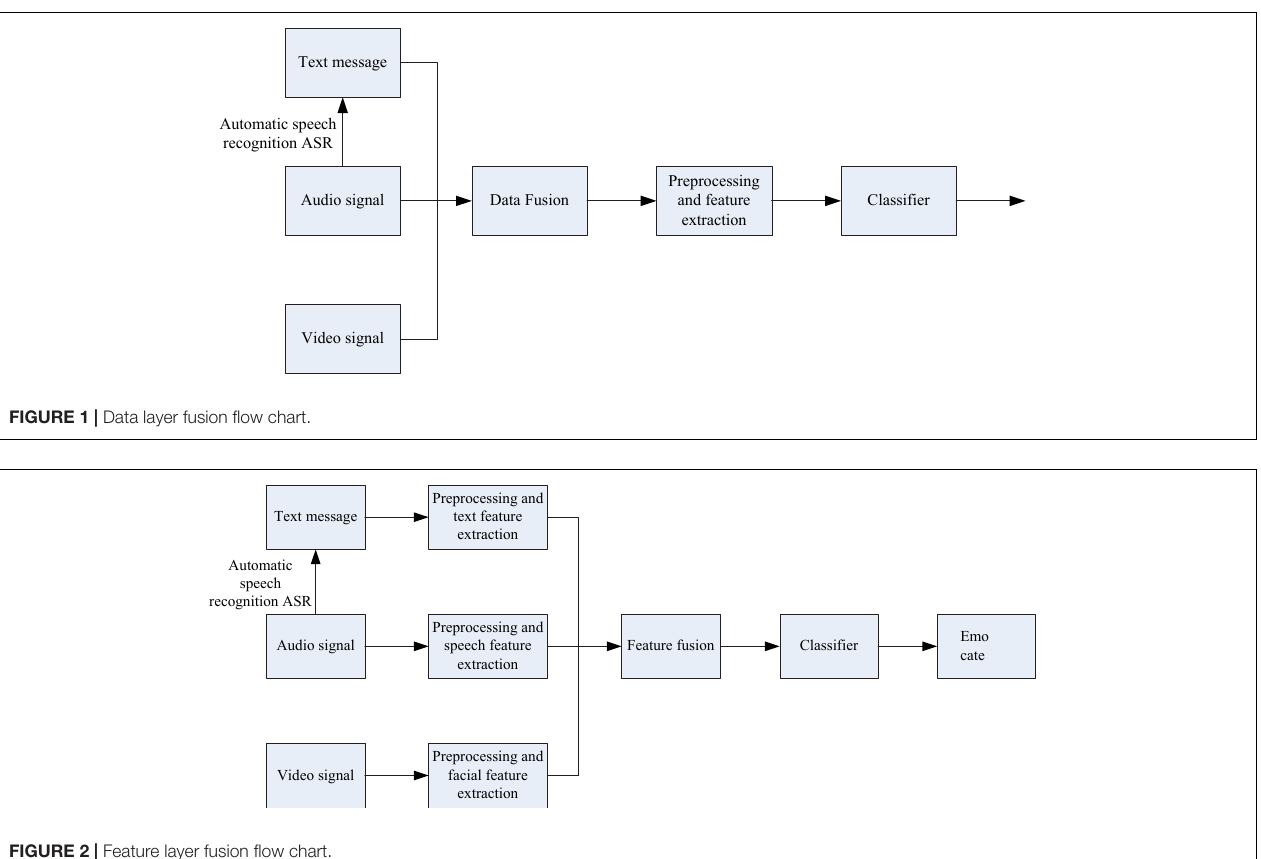
FIGURE 2 | Feature layer fusion flow